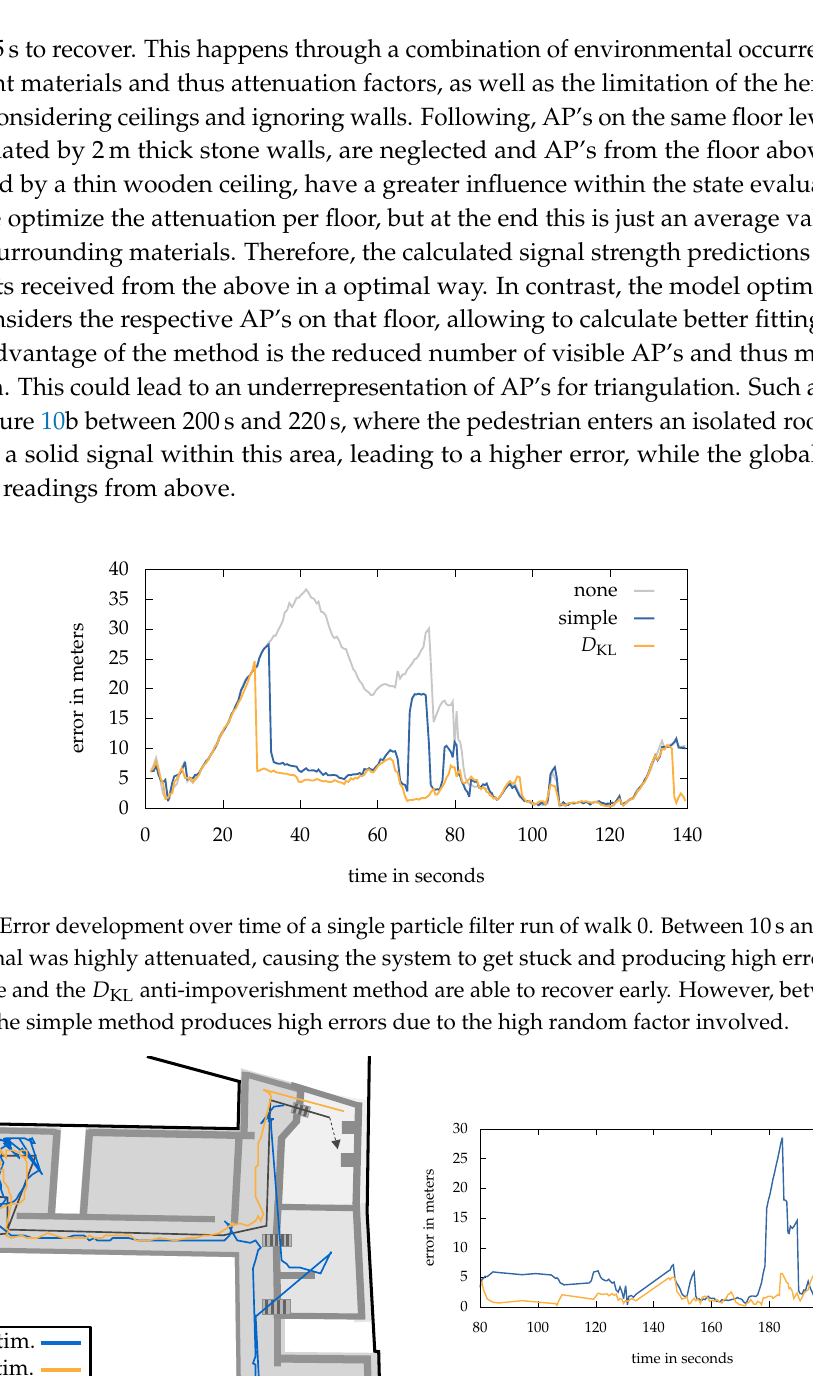
optim.global optim. local